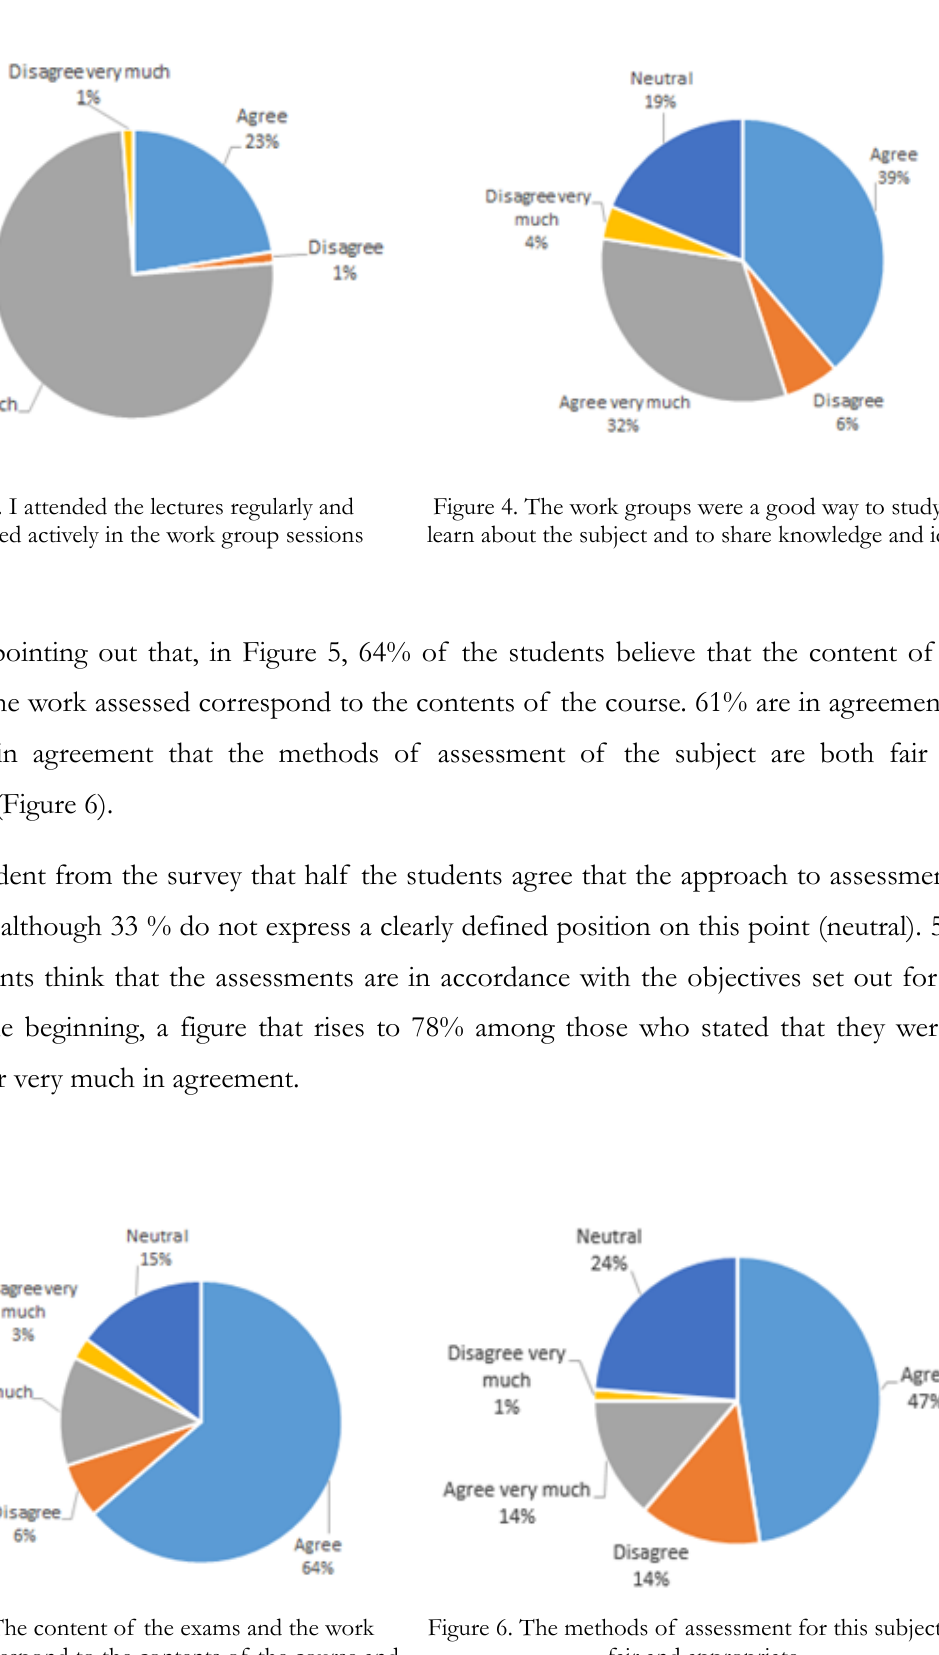
Figure 4. The work groups were a good way to study, to learn about the subject and to share knowledge and ideas